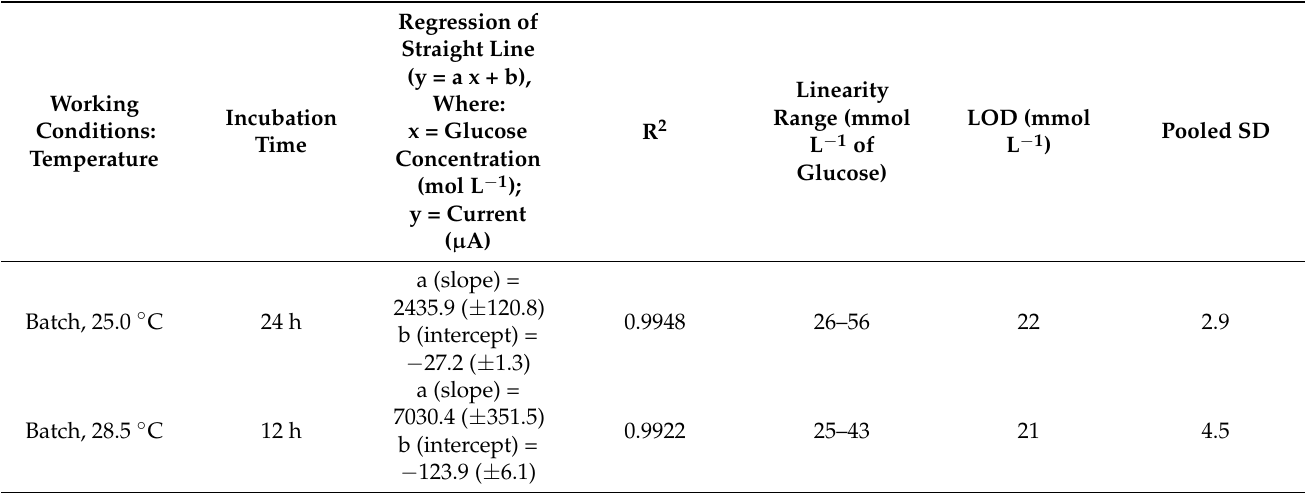
Table 1. Main analytical data using Direct Catalytic Fuel Cell (DCFC) as glucose sensor. Equation of calibration curves as current vs. glucose